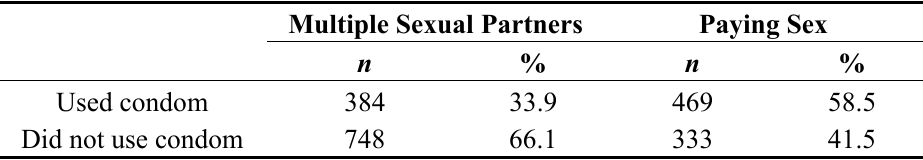
Table 6. Participants’ use of condoms at the last sexual encounter.